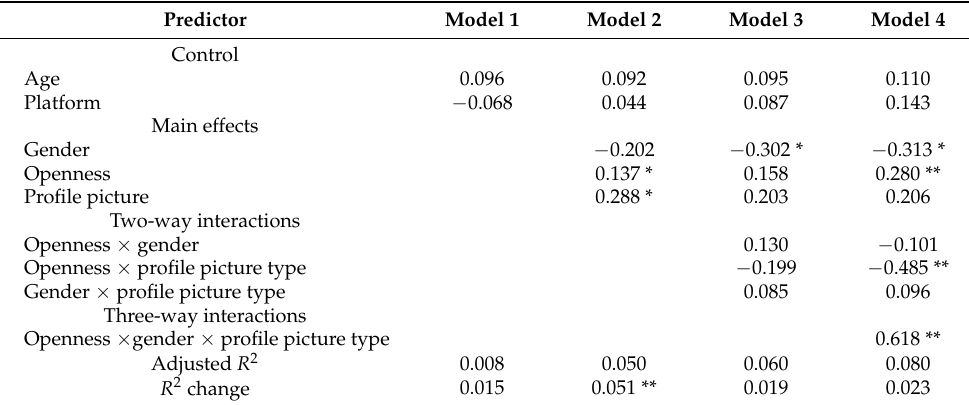
Table 2. Hierarchical multiple regression models for openness predicting life satisfaction.